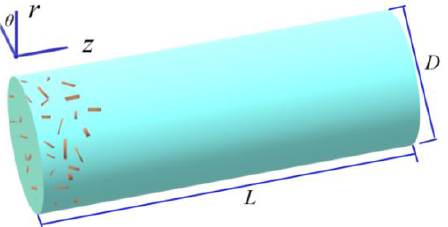
Figure 1. Flow laden with cylindrical particles in a pipe.